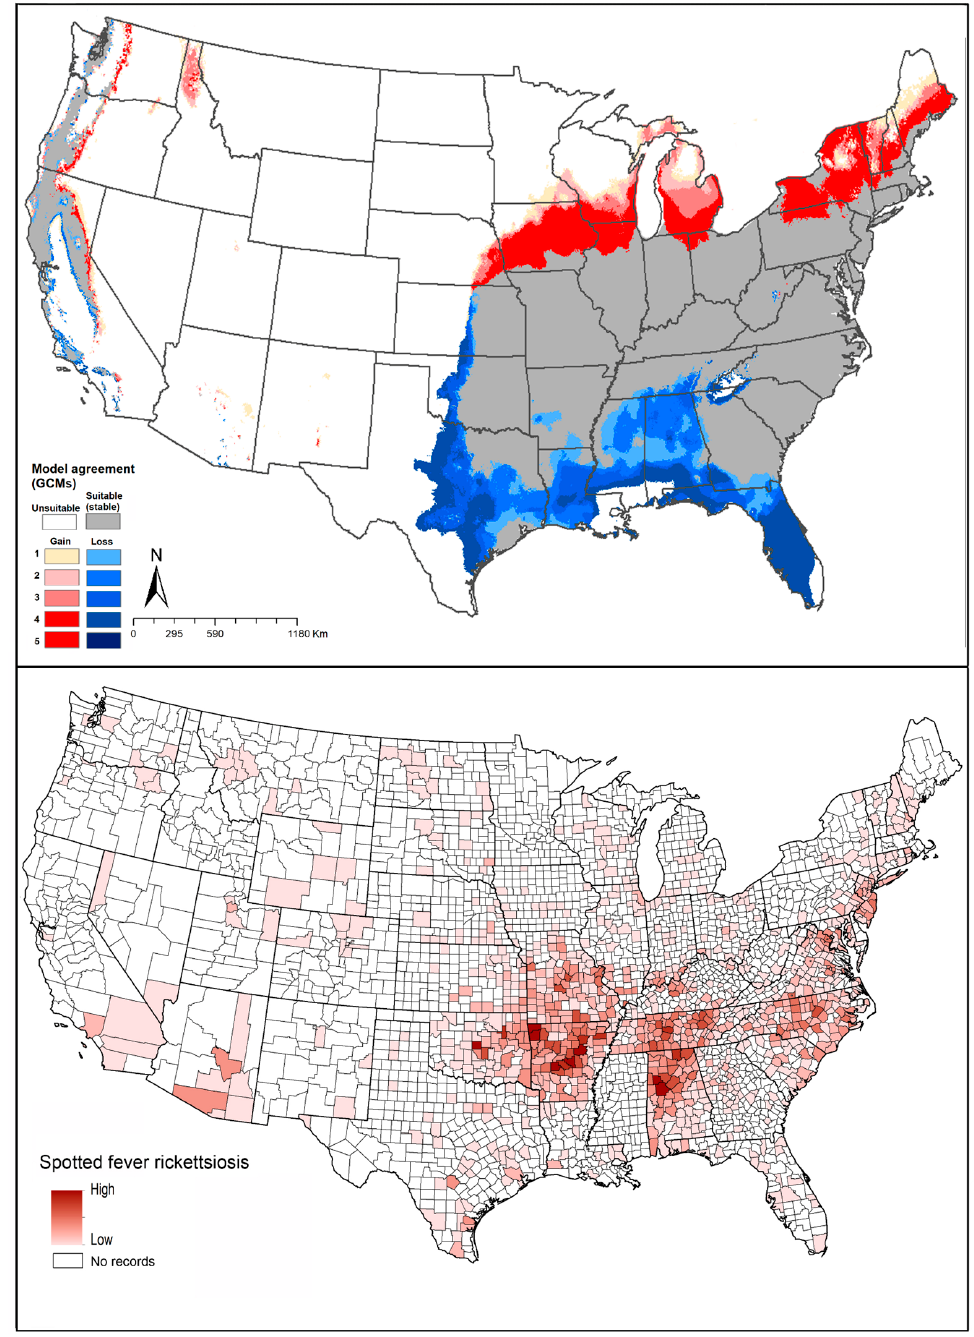
Figure 8. Geographic distribution of Amblyomma americanum and the disease that it likely transmits in the United States. Dark pink represents high incidence, light pink indicates low incidence. White represents no records.